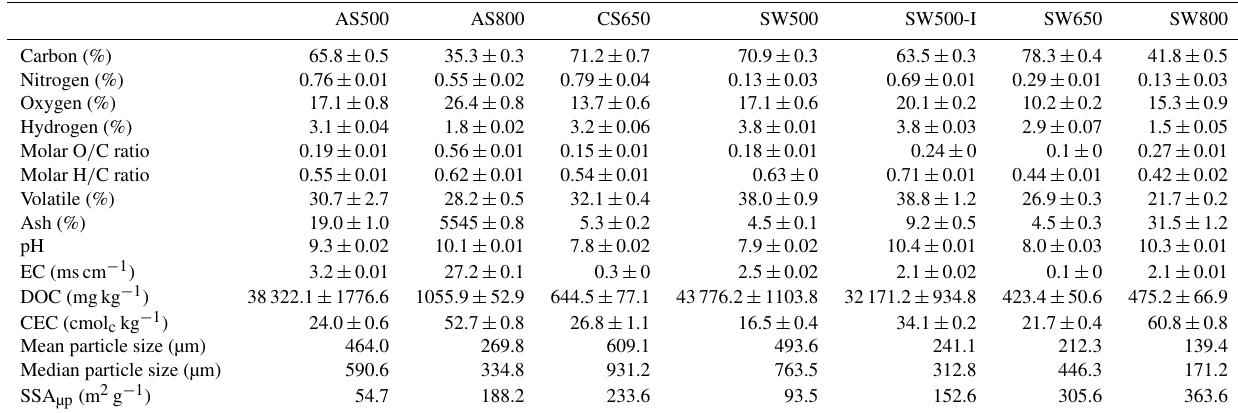
Table 1. Select chemical and physical biochar properties ( n = 3) ± SE of the means. AS500 AS800 CS650 SW500 SW500-I SW650 SW800 Carbon (%) 65.8 ± 0.5